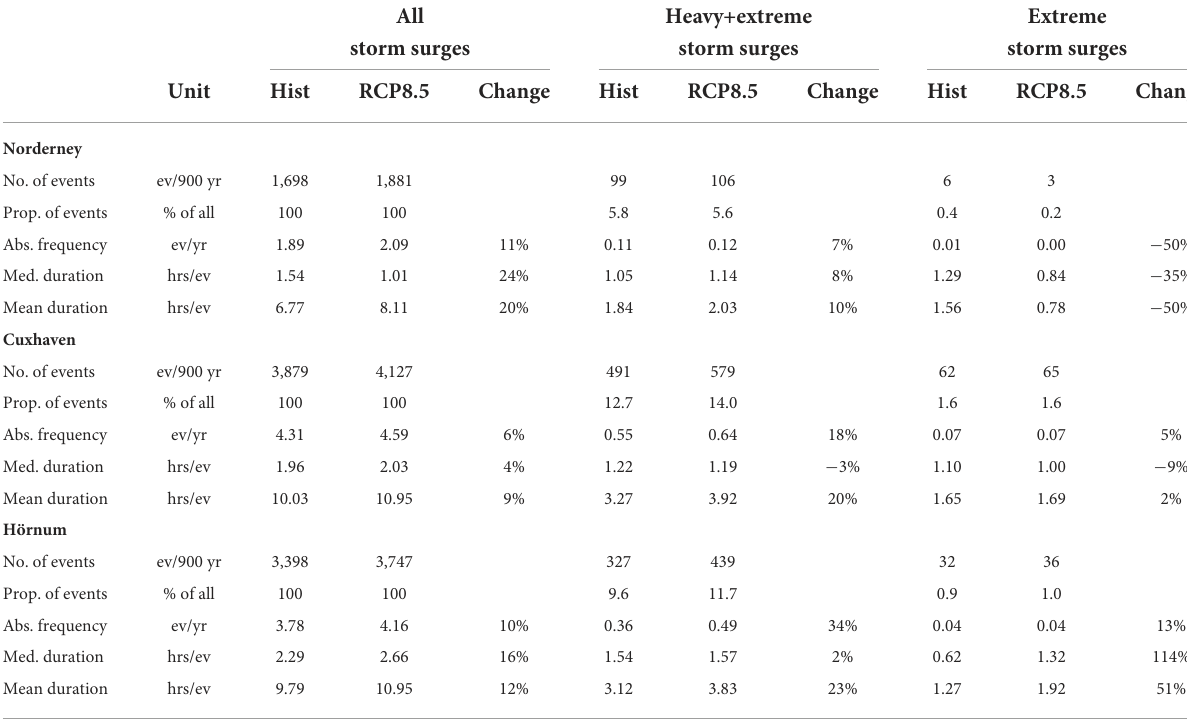
TABLE 1 Storm surge frequency and duration in historical and RCP8.5 pools and their changes. “prop.” means proportion, “abs.” means absolute, “med.” means median. All Heavy+extreme Extreme storm surges storm surges storm surges Unit Hist RCP8.5 Change Hist RCP8.5 Change Hist RCP8.5